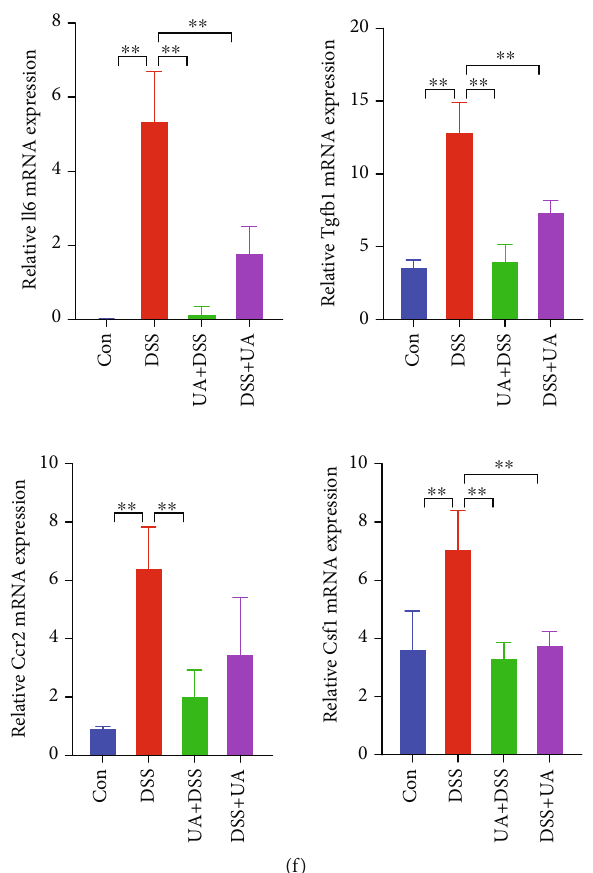
Figure 3: Transcriptome analysis and protein expression of the prevention and treatment of the DSS-induced UC model with UA treatment. (a) PCA analysis results of transcriptome under di ff erent treatments. (b) The KEGG signaling pathway enrichment results of black module genes by WGCNA. (c) Heatmap of ECM receptor interaction and TGF- β signaling pathway gene expression. (d) Heatmap of the cytokine- cytokine receptor signaling pathway gene expression. (e) Immunoblot analysis of Col1a1, Tgfb-1, and Itag5 in four groups of colonic tissues. (f) The relative mRNA expression of Il6, Tgfb-1, Ccr-2, and Csf-1 gene in four groups of colonic